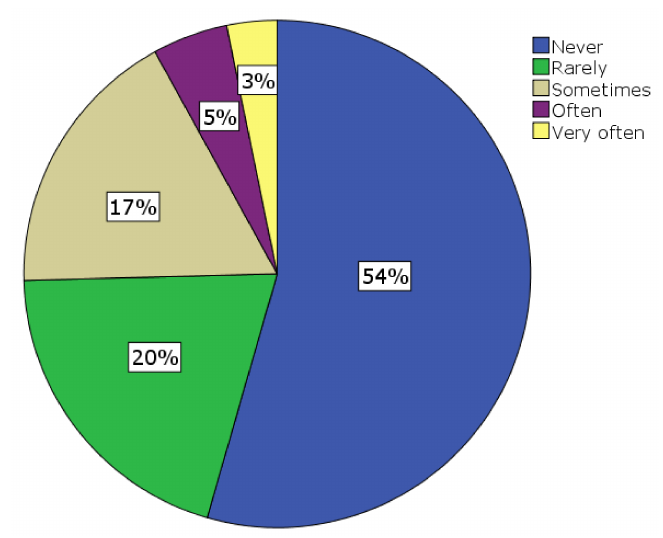
Figure 10. How often does the condition of the pavement and walkways prevent you from walking in